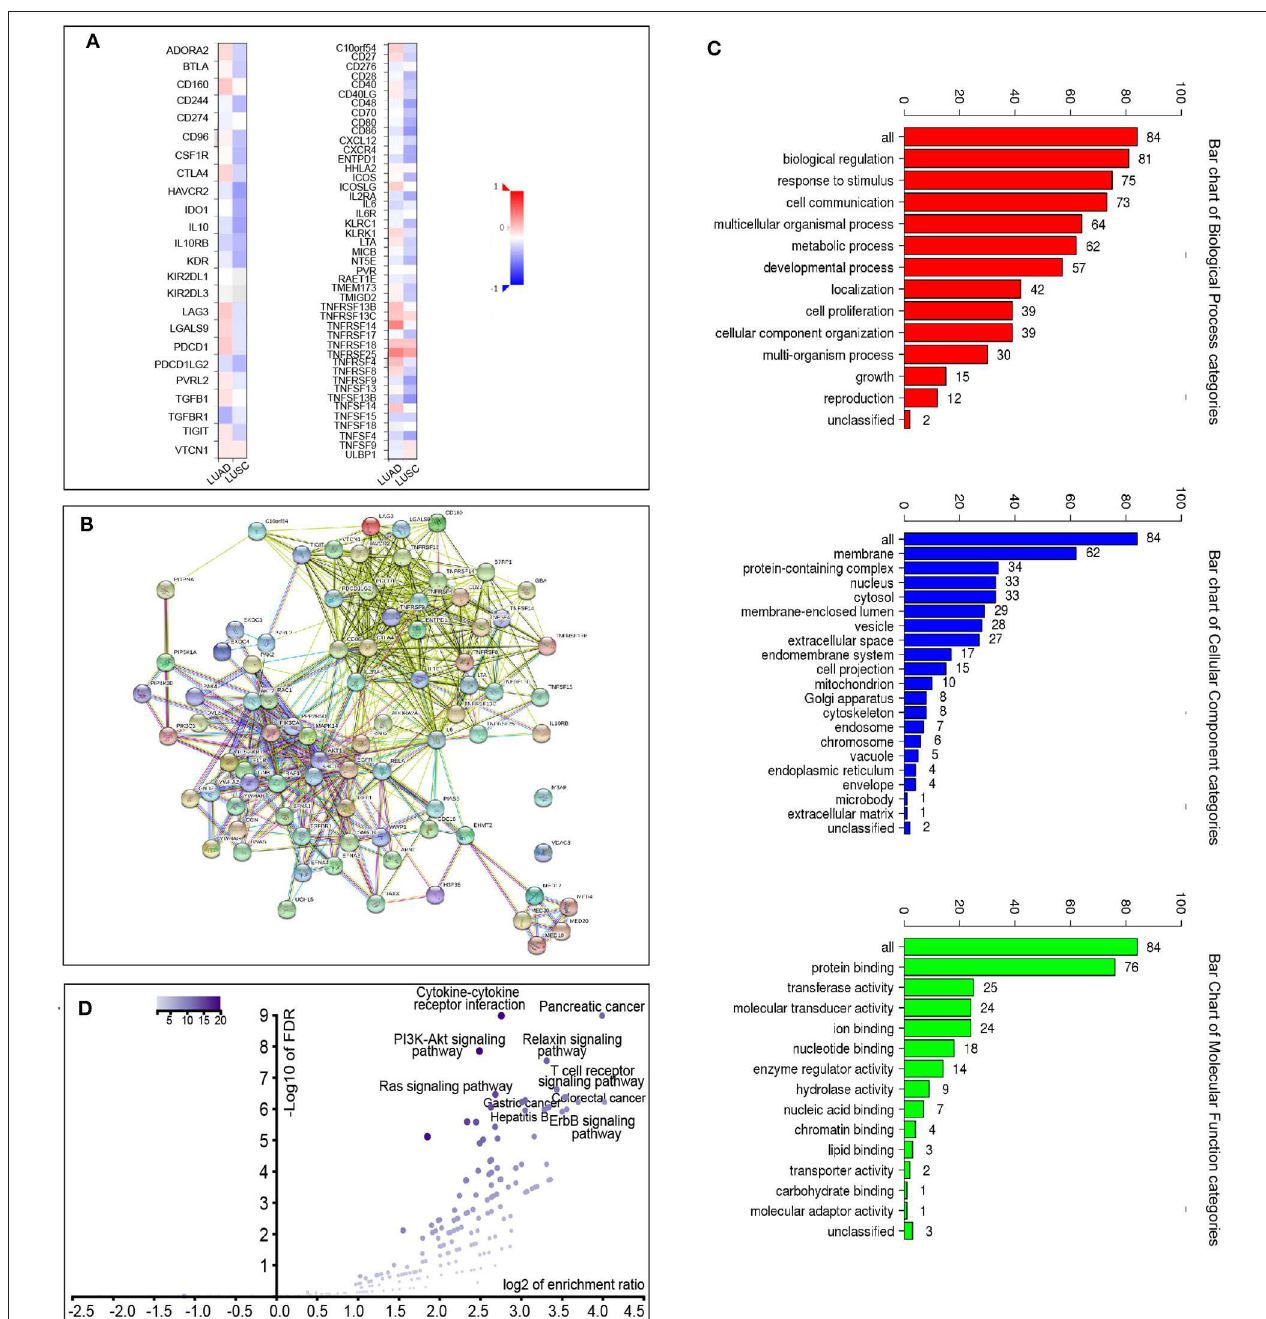
FIGURE 5 | Identification and analysis of immunomodulators associated with the ACK1 / TNK2 gene. (A) The heatmaps of correlation between the immunoinhibitors and the ACK1 / TNK2 gene (left panel) in LUAD and LUSC; the heatmap of correlation between the immunostimulators and the ACK1 / TNK2 gene in LUAD and LUSC (right panel). (B) Protein–protein network of 35 ACK1-associated immunomodulators and 50 closely related genes in LUAD, produced by the STRING online server. (C) Gene Ontology annotation of 35 ACK1-associated immunomodulators and 50 closely connected genes in LUAD. (D) Kyoto Encyclopedia of Genes and Genomes pathway analysis of the abovementioned 85